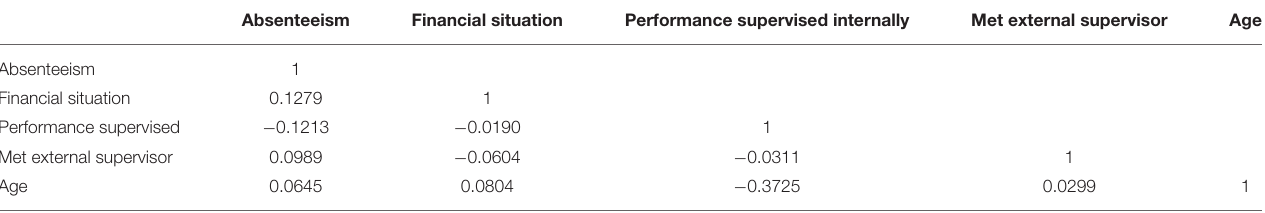
TABLE 3 | Correlation matrix.